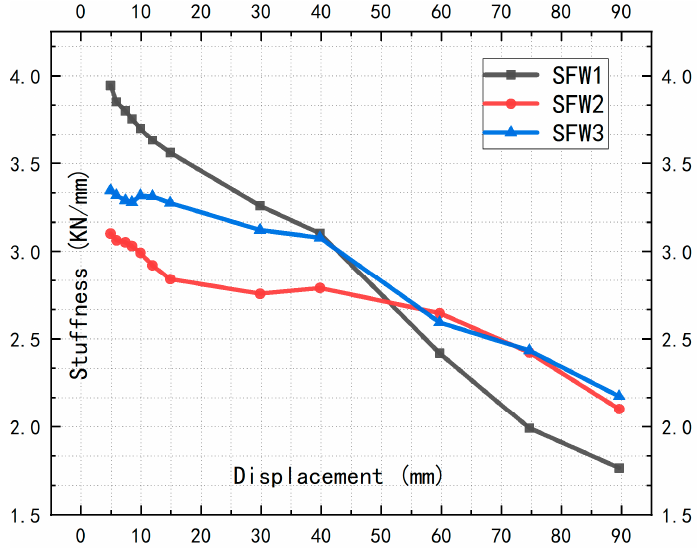
Figure 13. Deterioration of stiffness of specimens.